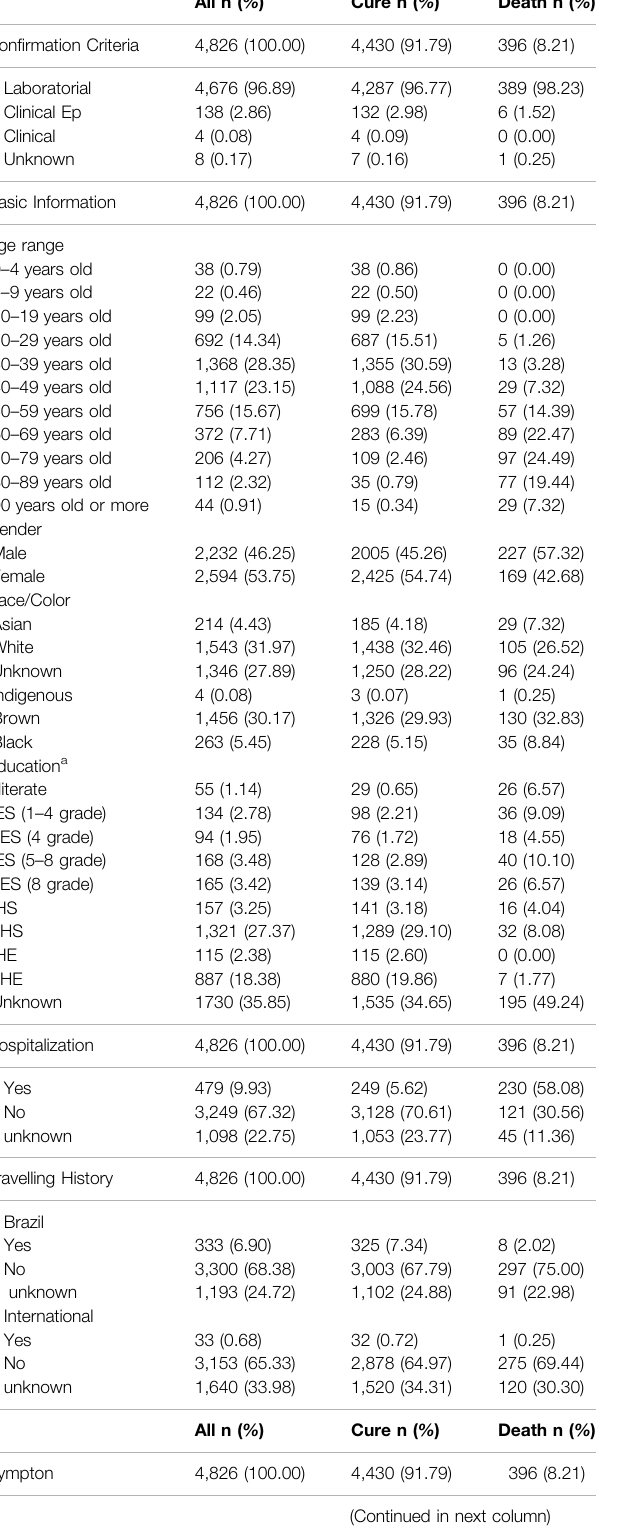
TABLE 1 | Demographic data and clinical characteristics of the study populationTraining Dataset (Feb 29th - May 23rd). All n ( % )